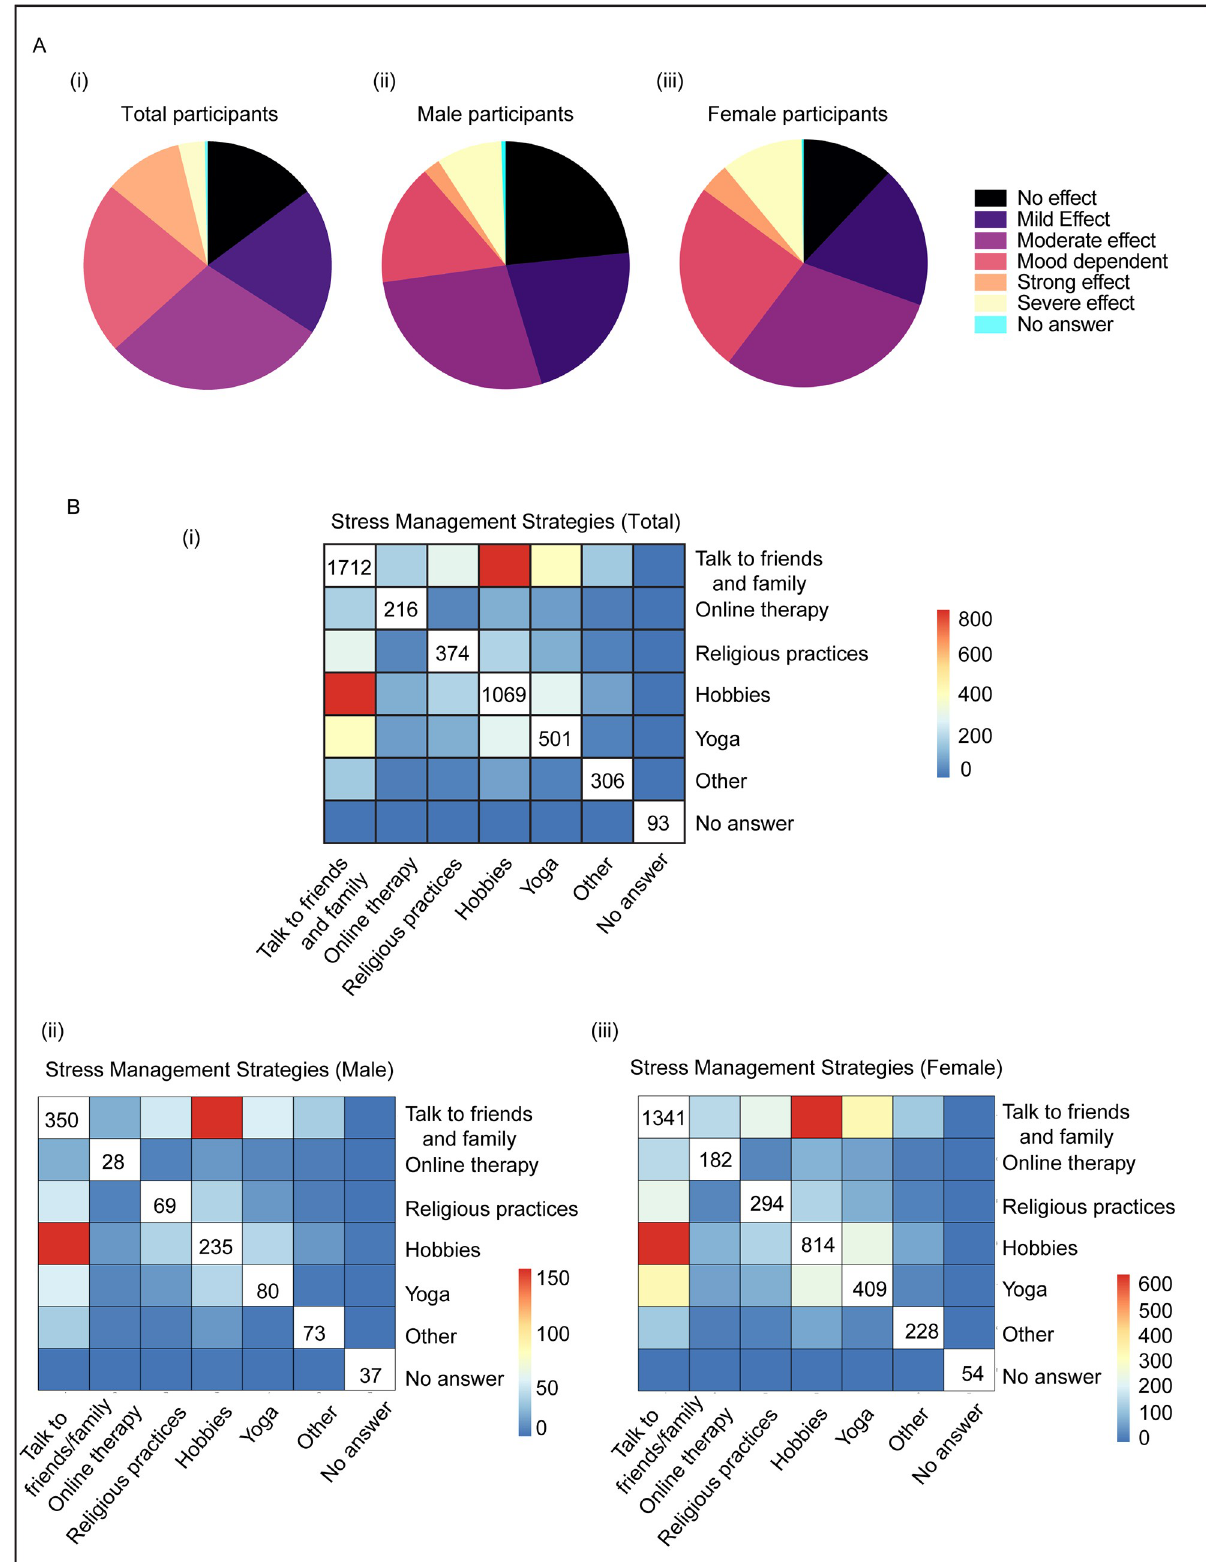
Fig 5. Effect on mental health of the study participants. A. Extent of mental health effect due to home isolation during the study period. (i: Total number of participants; ii: Male participants; iii: Female participants). B. Stress management strategies adopted by individuals. (i: Total number of participants; ii: Male participants; iii: Female